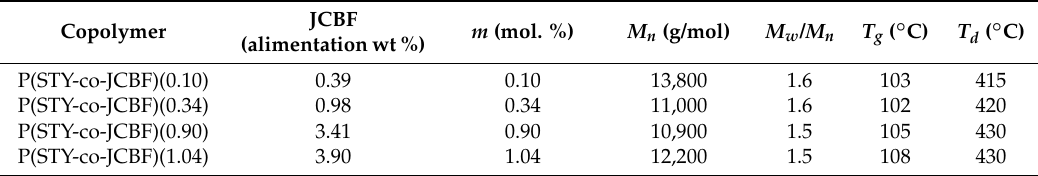
Table 1. Characteristics of the P(STY-co-JCBF) copolymers.